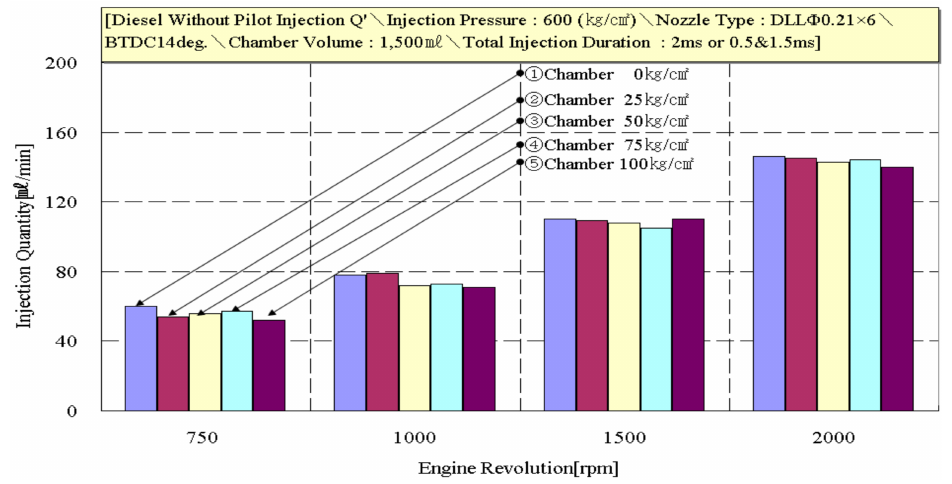
Figure 13. Injection quantity on engine revolution without pilot injection of diesel fuel.